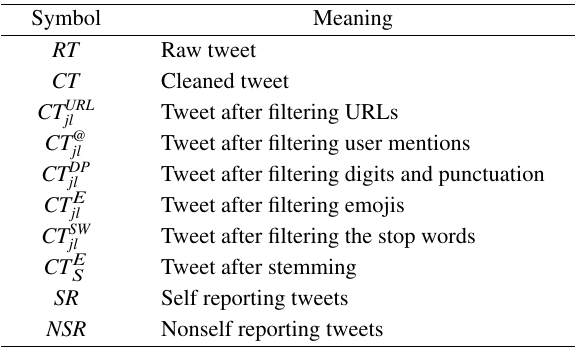
Table 1 Meaning of symbols.